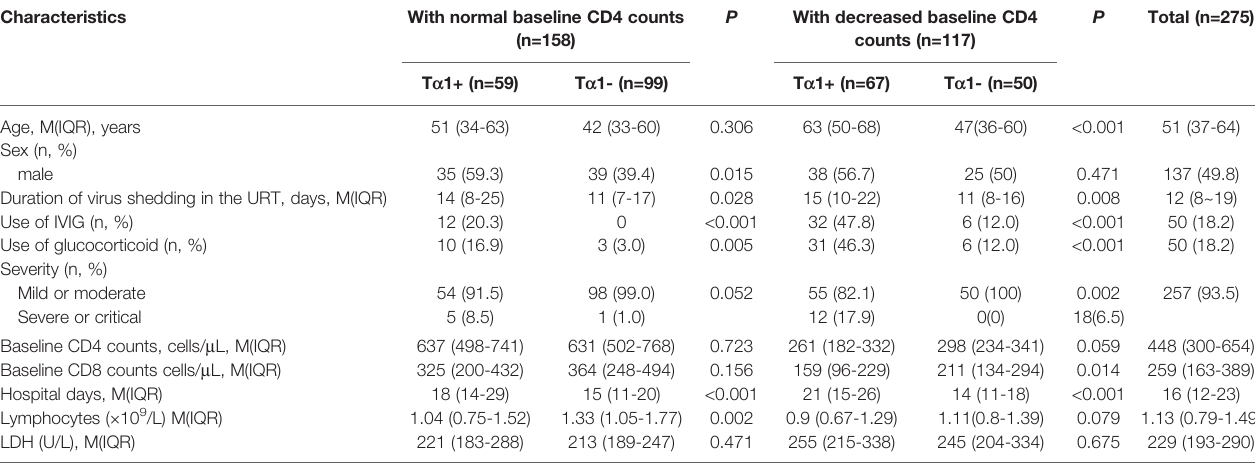
TABLE 2 | Characteristics of COVID-19 patients with and without therapy with T a